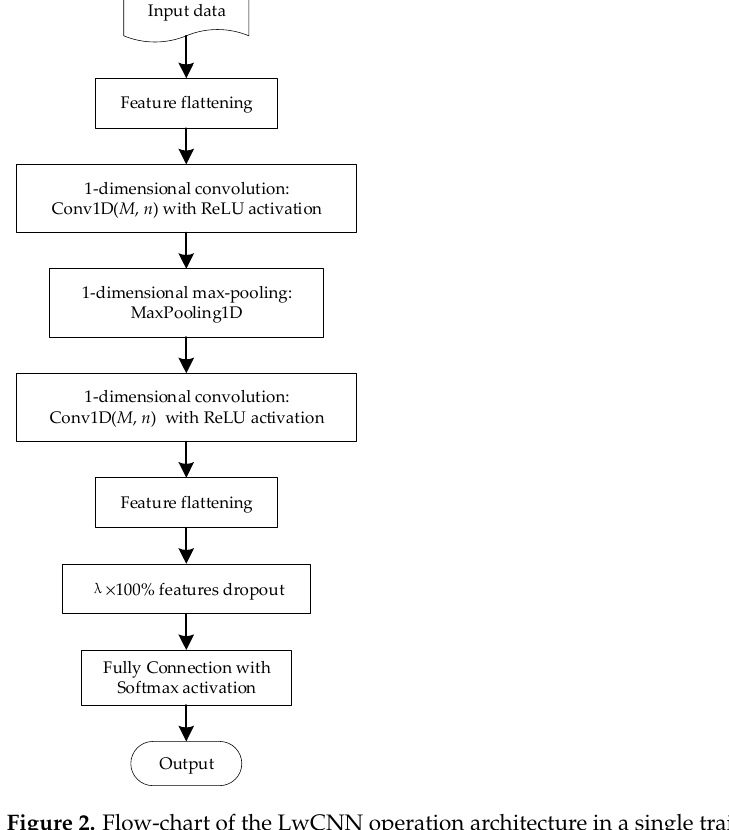
Figure 2. Flow-chart of the LwCNN operation architecture in a single training epoch.